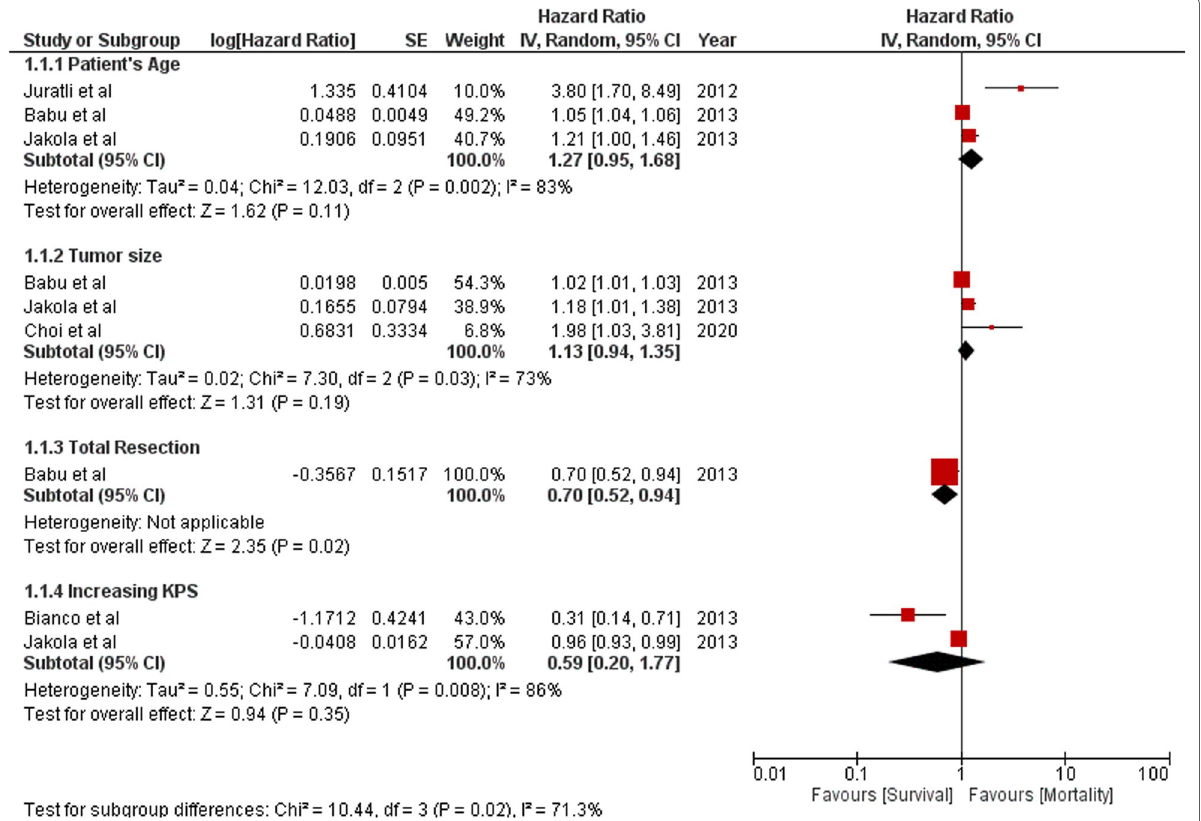
Fig. 2 Forest plot showing effect size of predictor factors of mortality in low-grade